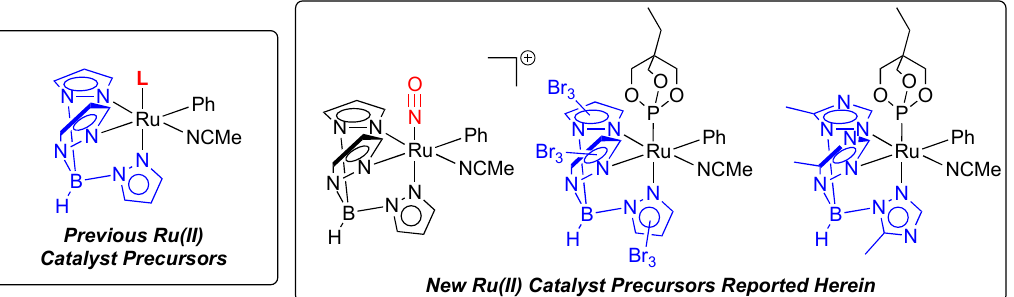
Scheme 1. New Ru(II) complexes with reduced electron density compared to TpRu(L)(NCMe)Ph